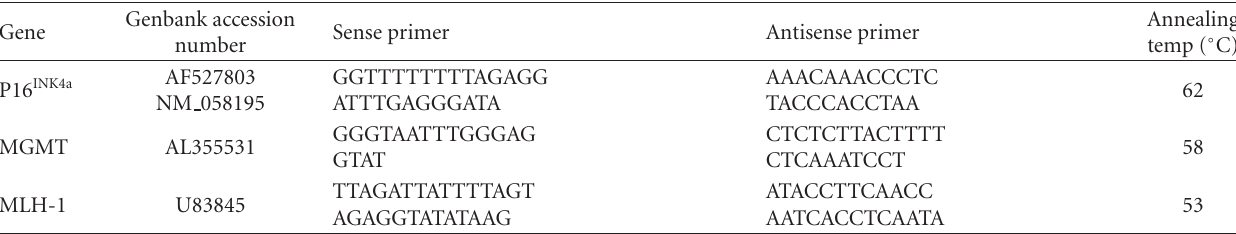
Table 1: Primers used in the amplification of CpG islands from bisulfite-treated DNA by PCR (nested PCR) including their sequences and annealing temperature.